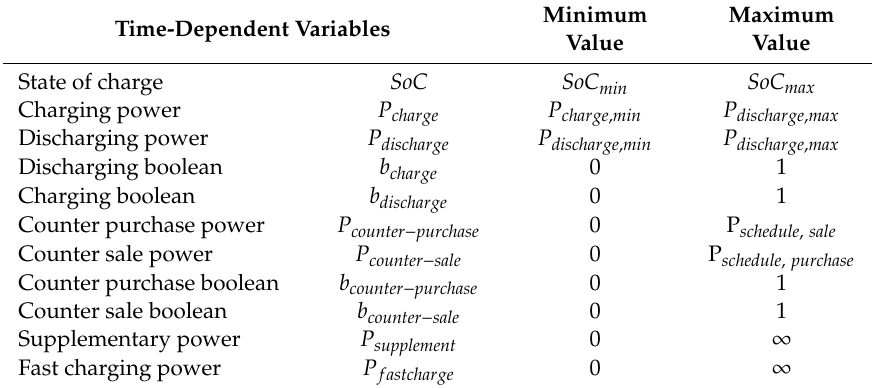
Table A1. List of time-dependent variables of the storage equation and their respective limit